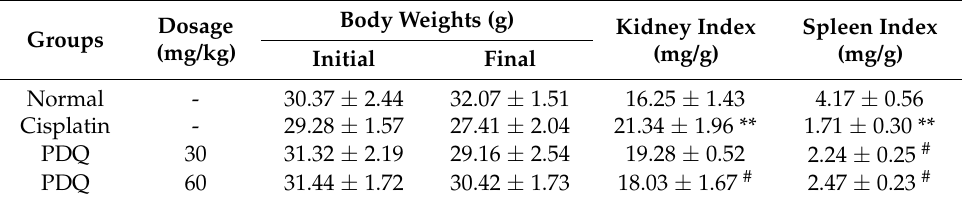
Table 1. Effects of PDQ (pseudoginsengenin of diol derivatives quest) on body weight change, kidney index, and spleen index in cisplatin-induced acute kidney